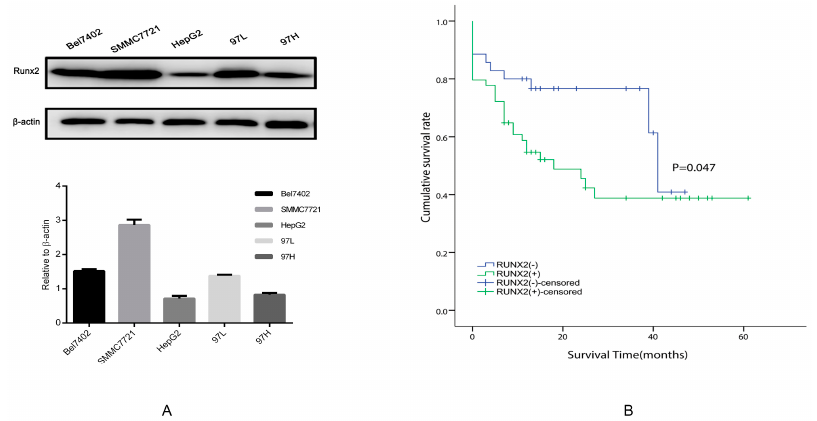
Figure 2. Cell line screening and survival analysis. ( A ) Runx2 protein levels in Bel7402, SMMC7721, HepG2, 97L, 97H cell lines were evaluated by Western blot analysis; ( B ) Overall survival of hepatocellular carcinoma patients with Runx2-positive and Runx2-negative.